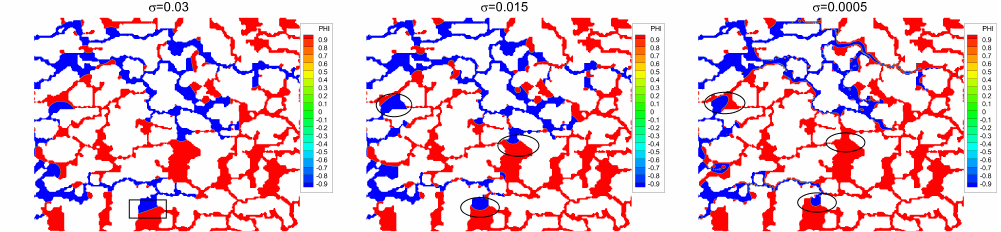
Figure 7. Fluid distributions at breakthrough for a wetting fluid invading a porous medium initially saturated with a non-wetting fluid. The wetting fluid (indicated in blue) is injected from the left side and the values of the interfacial tension are 0.03 mu · ts − 2 , 0.015 mu · ts − 2 , and 0.0005 mu · ts − 2 from the left to